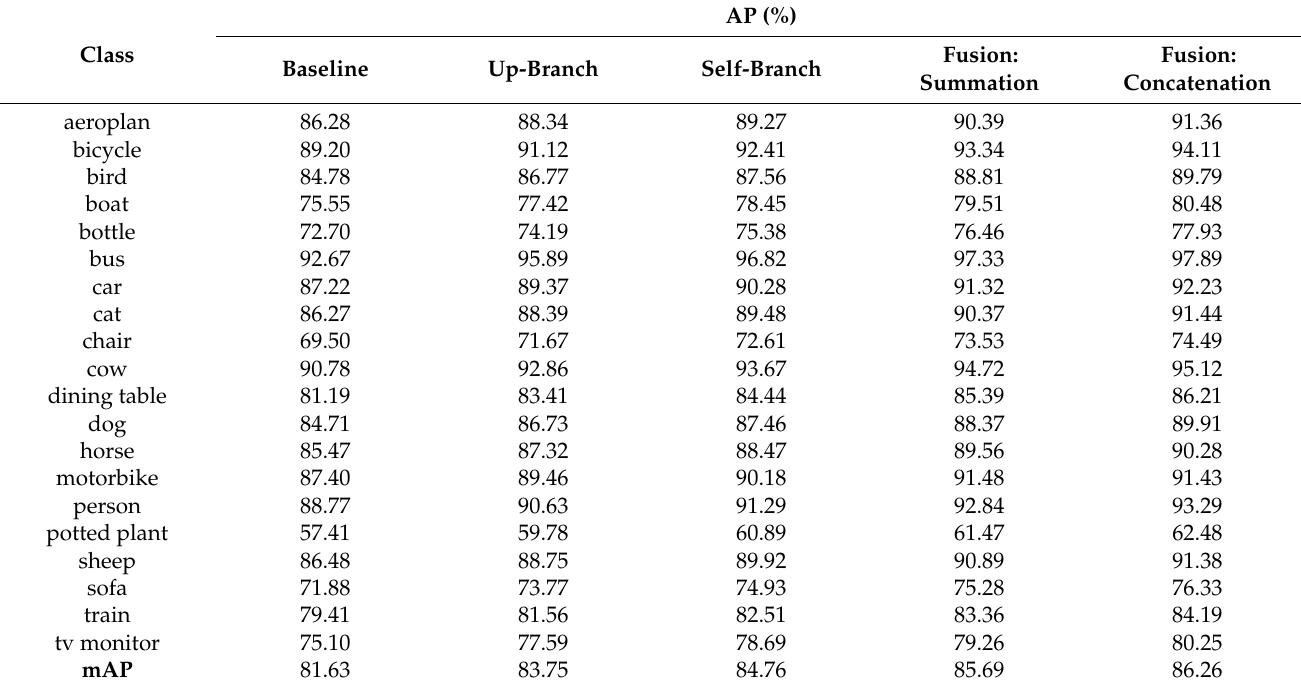
Table 1. Achieved results using the Pascal VOC 2012 dataset.